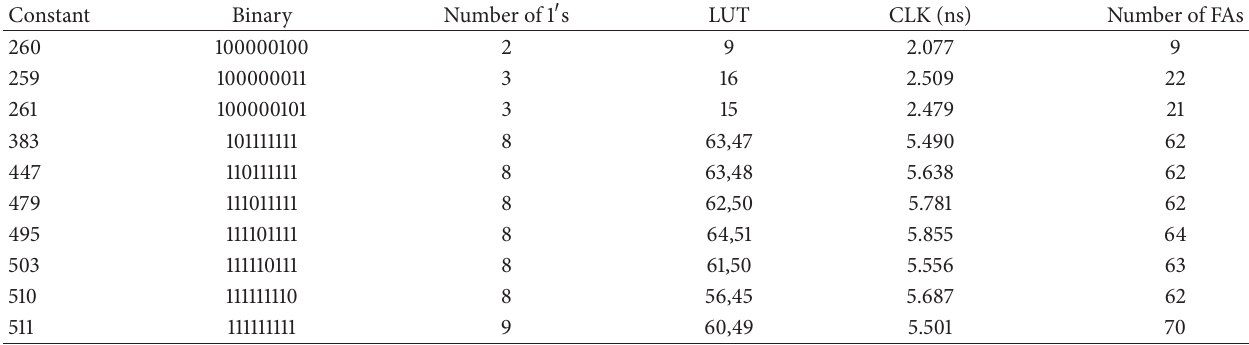
Table 10: Variation in LUT consumption for different 9-bit constants with the same number of 1 󸀠 s in binary representation.